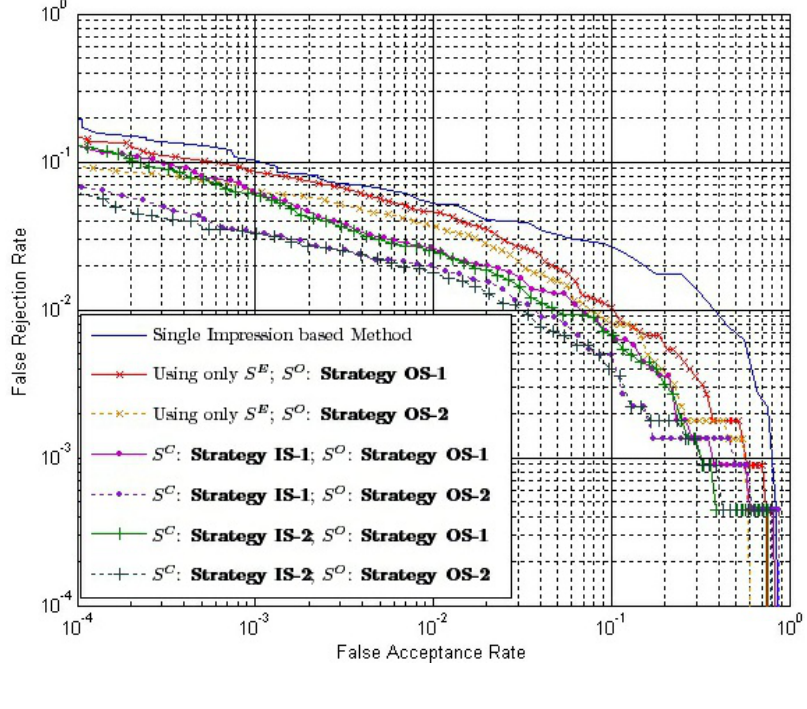
Figure 13. ROC of the final match score using different combinations of strategies with ω = 1.0 and the conventional method using single impressions for